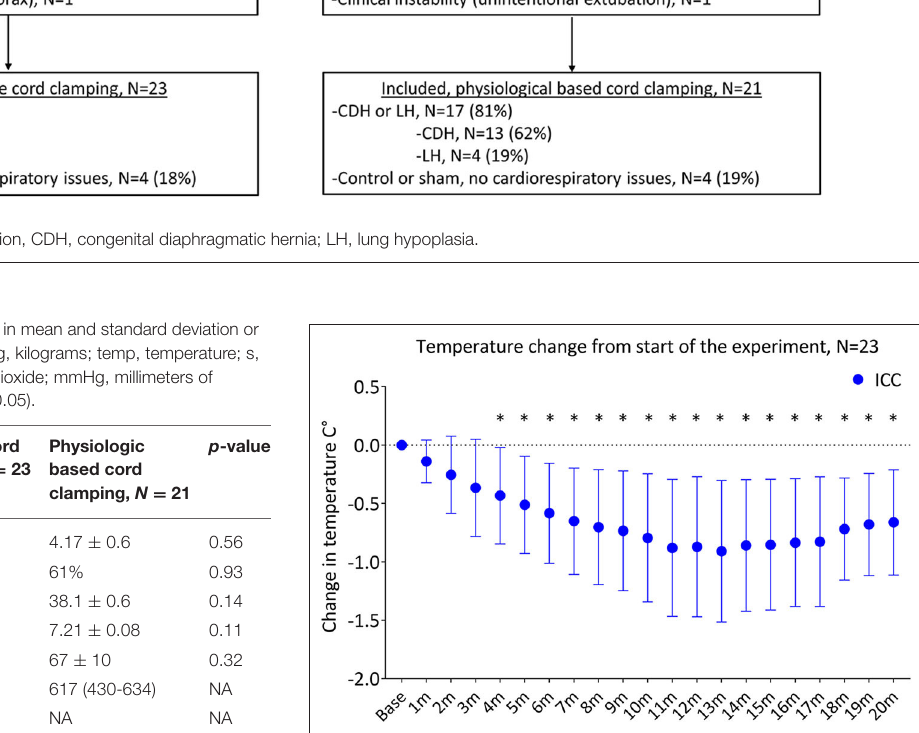
FIGURE 2 | Change in temperature from the start of the experiment in lambs receiving immediate cord clamping (ICC) displayed in mean ± SD using one-way repeated measures ANOVA with Bonferroni correction, m, minutes, *denotes significant difference ( p < 0.05) in temperature from